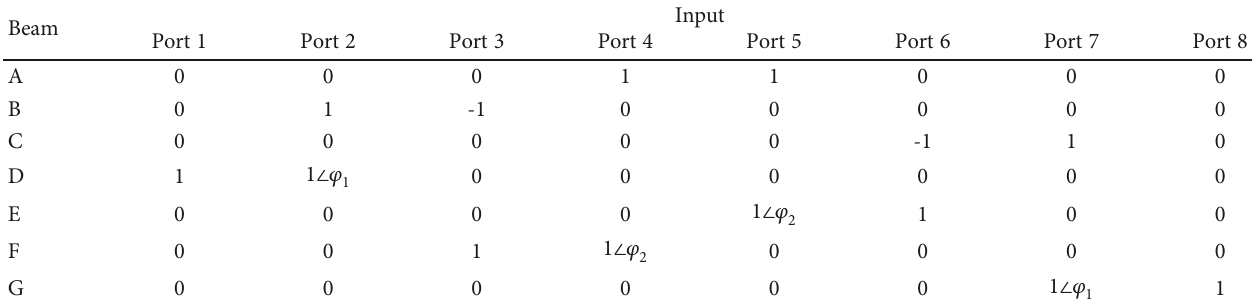
= − 202 5 ∘ , φ = − 157 5 ∘ ). 1 2